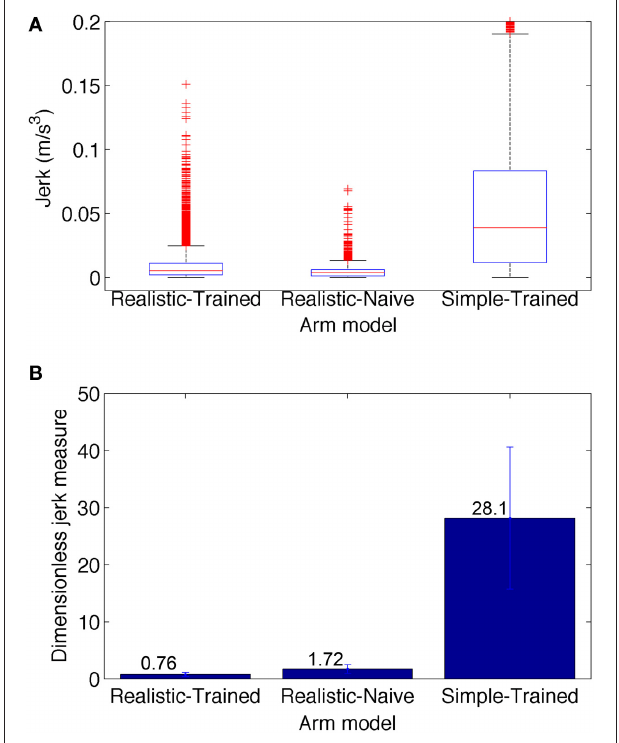
FIGURE 7 | Jerk-based comparison of smoothness for the three conditions depicted in Figure 6: realistic arm and trained network (left), realistic arm and naive network (center), and simple arm and trained network (right). (A) Boxplot statistics of the jerk (rate of change of acceleration). (B) Dimensionless jerk measure, which quantifies jerk but is independent of trajectory amplitude and duration. The dimensionless jerk measure was lower for the realistic musculoskeletal arm as compared to the simple arm, both in the naive and trained networks. Jerk was calculated based on reaching movements obtained from the best 30 metaparameter configurations for each case. Number of points = 5700 for each condition; number of outliers (red crosses) = 481 (Realistic-Trained), 581 (Realistic-Naive), and 297 (Simple-Trained; not shown for